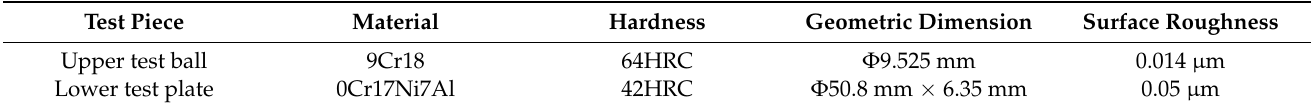
Table 4. Experimental conditions for rotation